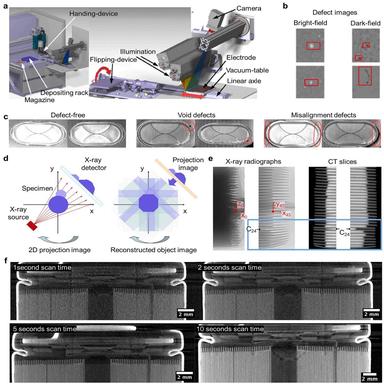
In-line optical and X-ray imaging inspection for battery manufacturing. (a) An illustration of optical imaging inspection system for battery electrode slitting. (b) Inspection results of contaminated electrode samples. Reproduced with permission. Copyright 2012, Elsevier. (c) Optical imaging results of battery safety vent. Reproduced with permission Copyright 2020, MDPI. (d) A schematic illustration of the principles of X-ray radiography and CT. Reproduced with permission